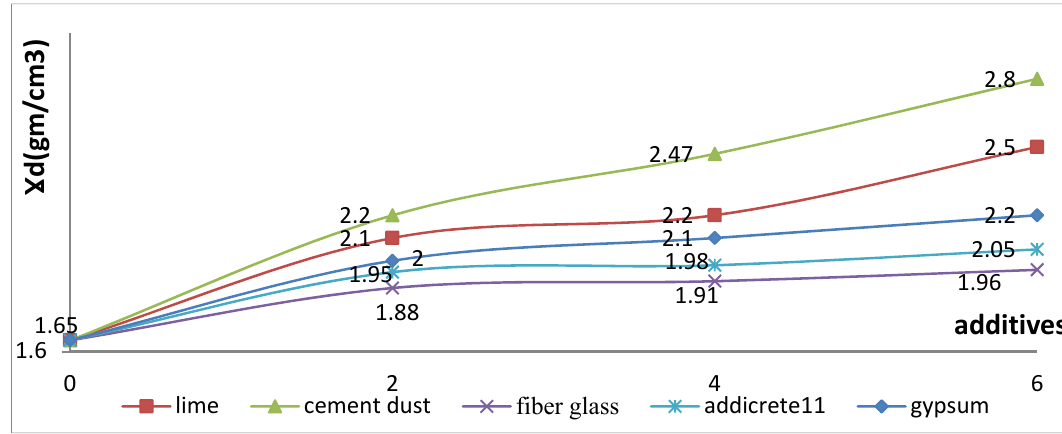
Figure 20. Effect of additives on maximum dry density.